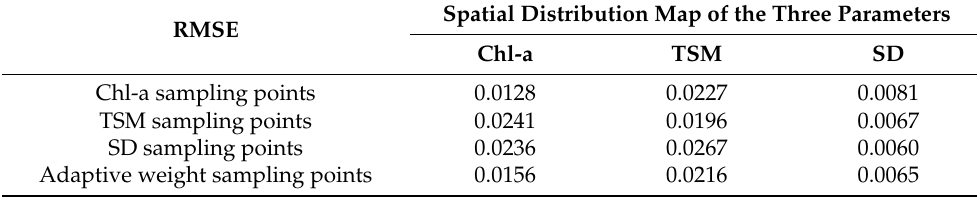
Figure 9. Multi-parameter sampling points in Nanyi lake ( a – c ), and the MRE of the in-situ and sim- ulated data ( d–f ), and the black dots are the simulated data, and the red dots are the in-situ data. Figure 10 displays the 15 sampling points and the MRE of the in-situ data and simu- lated data in Bosten Lake. On the one hand, The MRE of the adaptive weight sampling